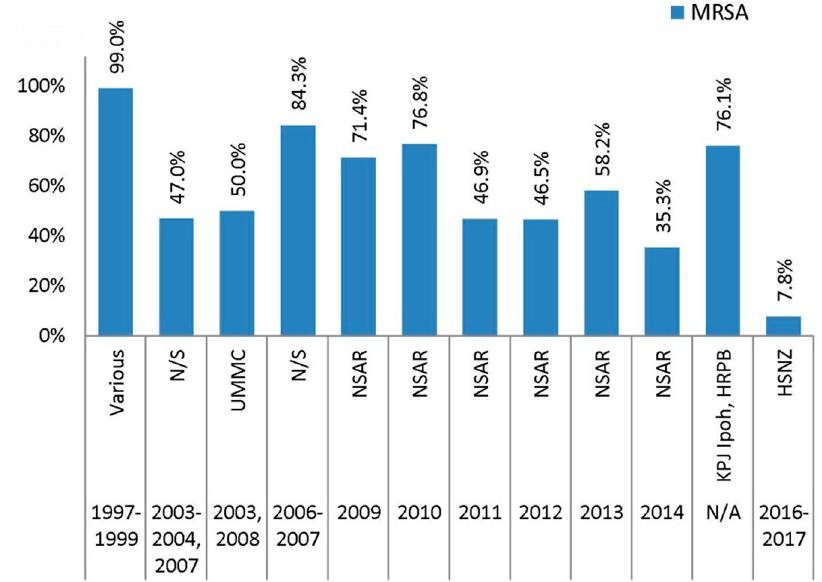
Figure 5. The prevalence of tetracycline resistance among Malaysian MRSA isolates, 1997–2017. Data from the NSAR reports; Various, collected from ten hospitals throughout Malaysia between 1997 and 1999 [14]; not specified (N / S) between 2003 and 2004 and in 2007 [16], and between 2006 and 2007 [17]; UMMC in 2003 and 2008 [18]; KPJ and HRPB with an unspecified year of collection [37]; and HSNZ between 2016 and 2017